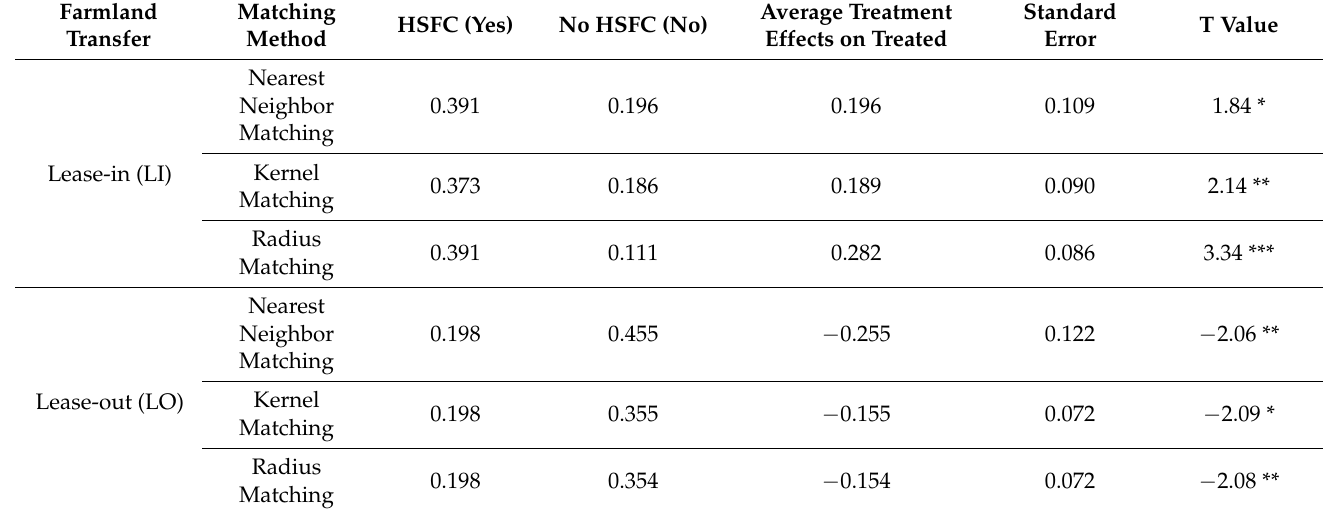
Table 3. Result of robustness